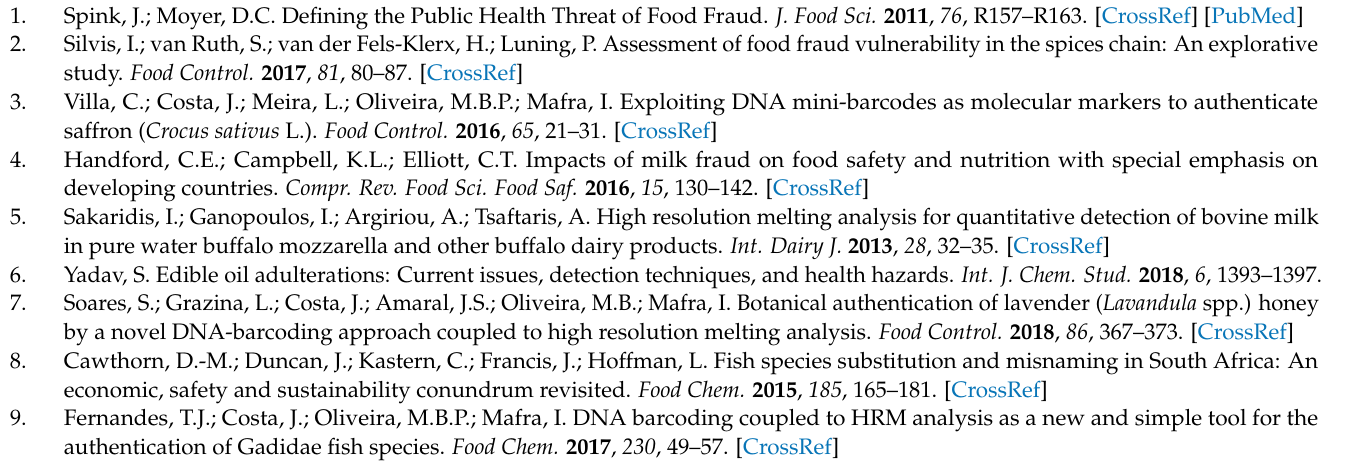
Figure S2: Box plots of peak PCR-HRM melting temperatures of DNA from meat samples exposed to different physicochemical conditions, Figure S3: PCR-HRM distinction of double-peaked profiles, Figure S4: Box plots of peak PCR-HRM melting temperatures of DNA extracted from meat samples using different